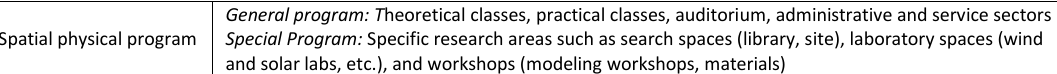
Table 5 . Example of special-physical